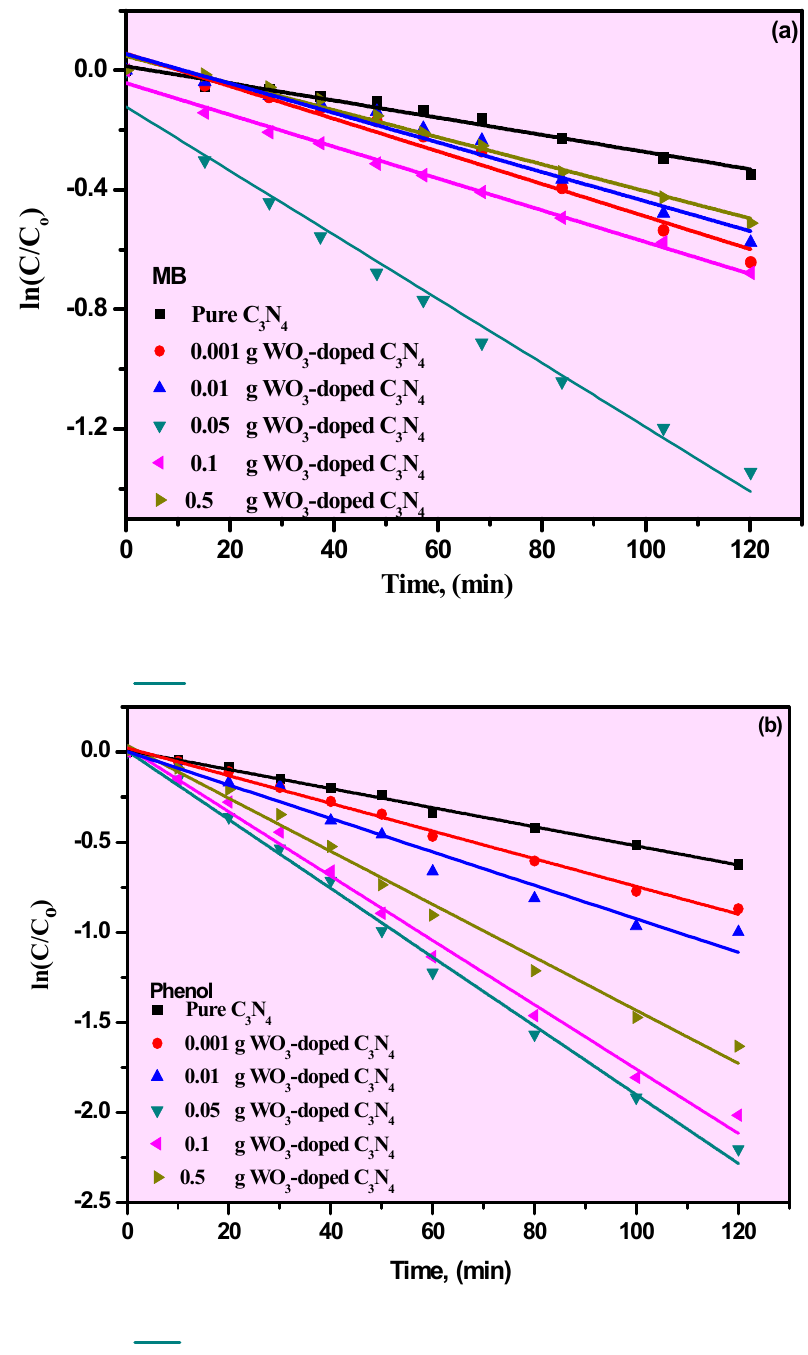
Figure 5. ( a , b ) The kinetic degradation curves of MB ( a ) and ( b ) Phenol for pure g-C 3 N 4 and its WO 3 /g-C 3 N 4 nanocomposites.